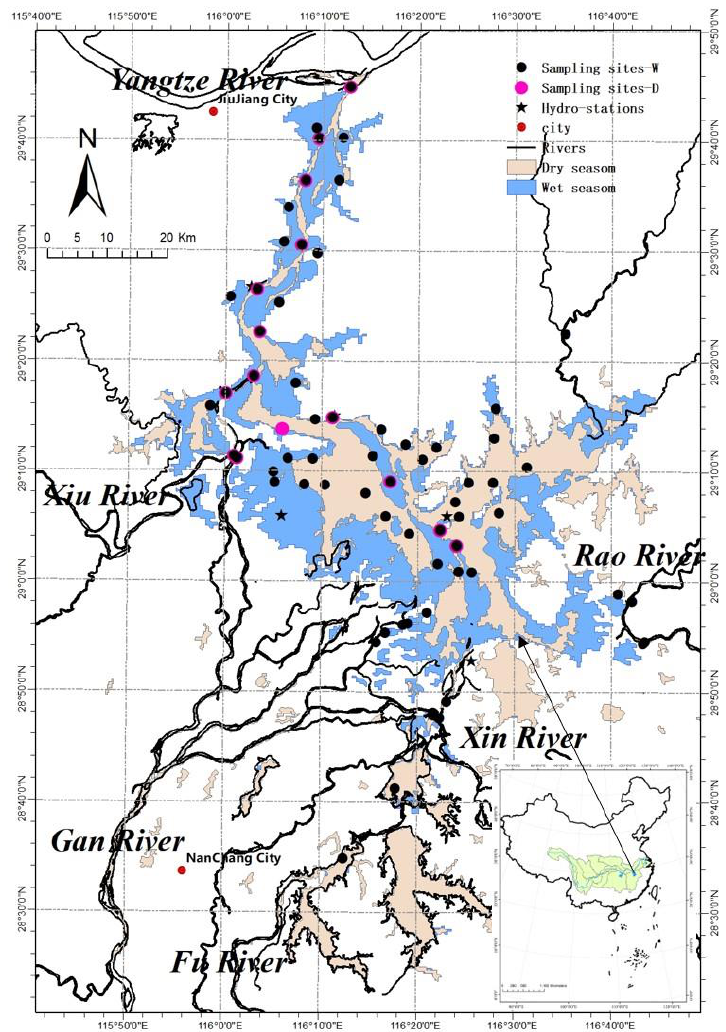
Figure 1. Location of Poyang Lake.